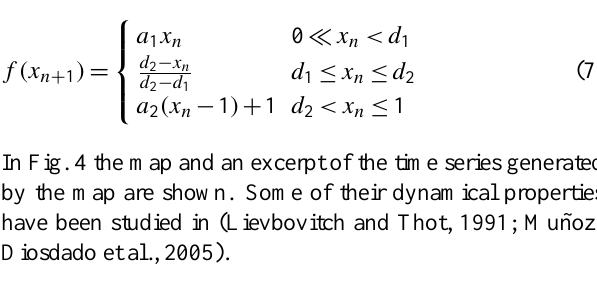
Fig. 3. Excerpt of ACA1 on 21 October 1993, in conventional time (top) and in NTD (bottom). Figure 3. Excerpt of ACA1 on October 21, 1993, in conventional time (top) and in NTD (bottom).